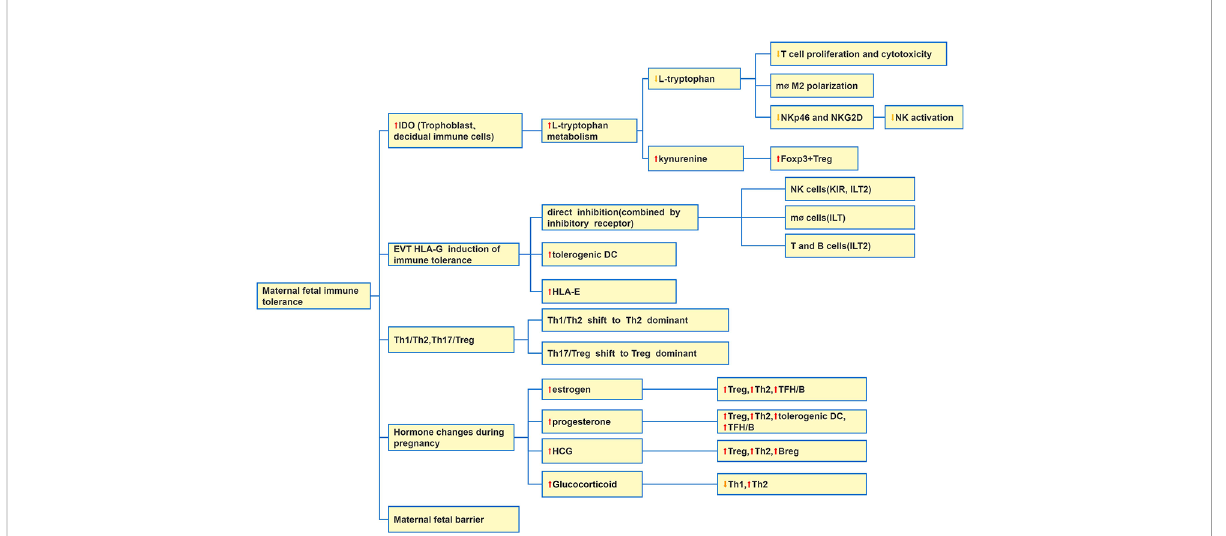
FIGURE 1 Causes of maternal fetal immune tolerance. There are fi ve main reasons: IDO at the maternal-fetal interface increases which induces maternal fetal immune tolerance; EVTs express HLA-G to induce immune tolerance; Changes of Th1, Th2, Th17 and Treg balance; hormone change during pregnancy; maternal-fetal barrier. Abbreviation: Extraxtravillous Trophoblast